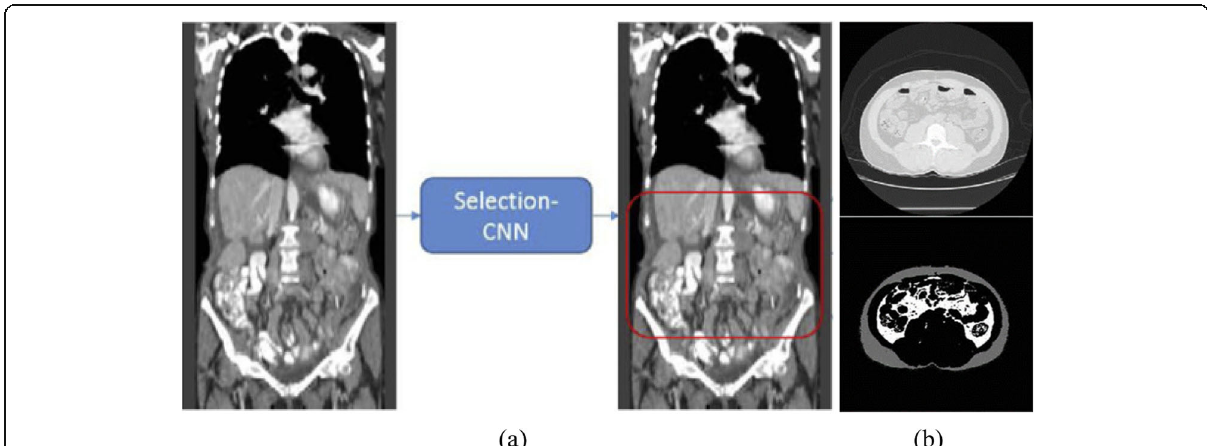
Fig. 5 Applying a convolutional neural network (CNN) algorithm ( a ) to automatically identify the targeted abdominal region marked inside a red frame and segmenting each selected abdominal CT slice into three groups of pixels, namely, SFA (light gray), VFA (white), and other human organs (dark) ( b )